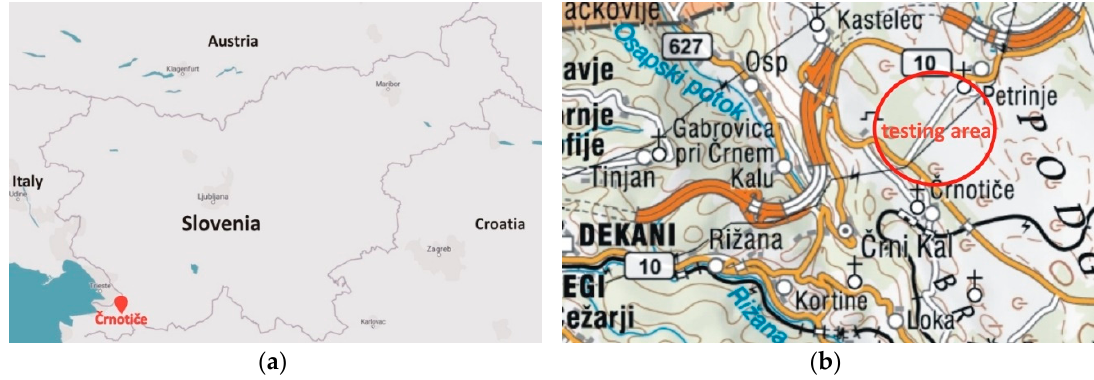
Figure 1. Geographic position of the testing area: ( a ) location of the village Č rnoti č e in Slovenia and ( b ) approximate location of the testing area (red circle) [42,43]. Table 1. Locations of instruments at location B in the Slovenian realisation of the coordinate system ETRS89; instruments were set up in a line. Heights H were acquired from the ellipsoidal heights h by using the SLO_VRP2016/Koper geoid model.